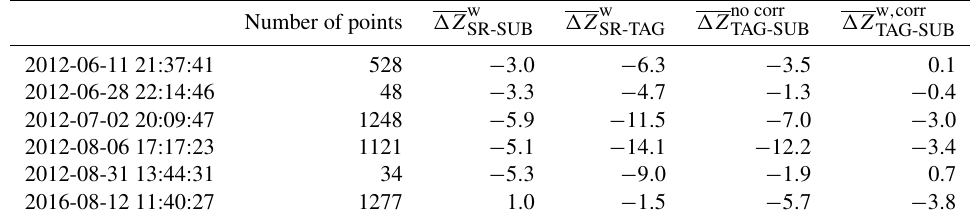
Table 3. Calibration biases and inter-radar consistencies for different bias calculation scenarios. Number of